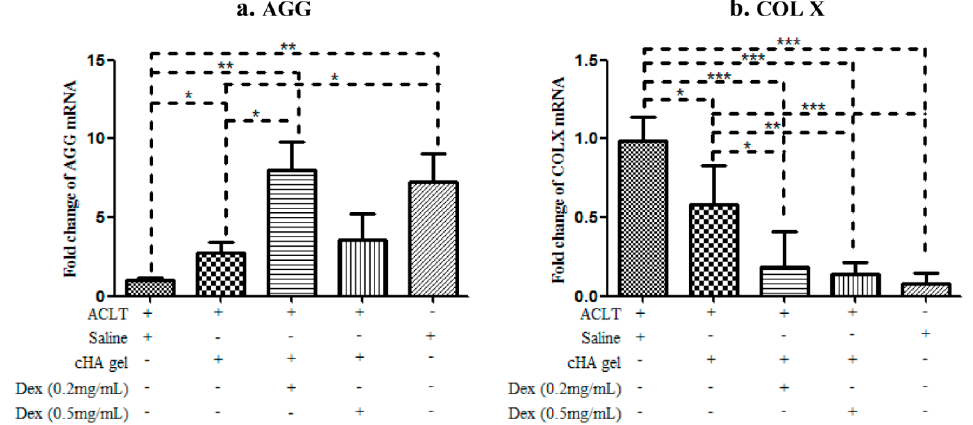
Figure 6. Intra-articular cross-linked hyaluronic acid-dexamethasone (cHA-Dex) hydrogel injections increased aggrecan (AGG) and decreased type X collagen (COL X) gene expression. ( a ) The mRNA level of AGG was increased in the cHA-Dex (0.2 mg/mL) gel group compared with the ACLT + saline or cHA only groups ( p < 0.05), suggesting a positive impact of the cHA-Dex gel on anabolic metabolism. ( b ) In contrast, COL X was decreased compared with the ACLT + saline or cHA only groups ( p < 0.05). Data were expressed as means ± SD. * represents that the difference was statistically significant, * p < 0.05, ** p < 0.01 and *** p < 0.001. n = 10.